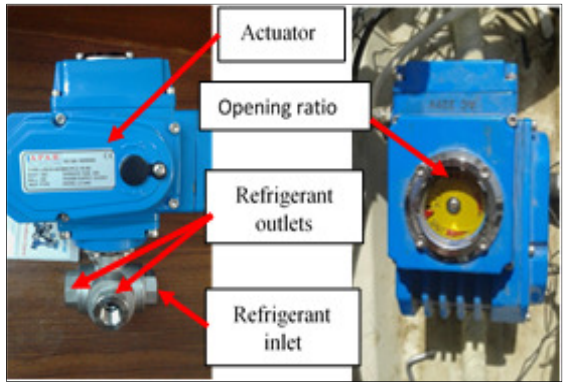
Fig. 5. Three-way control